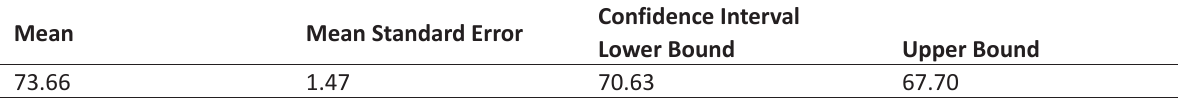
Table 7. Adjusted Mean after Eliminating the Effect of Pretest